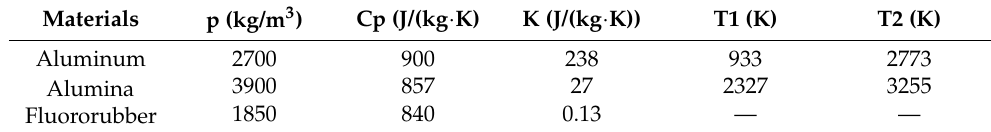
Table 2. The thermal performance